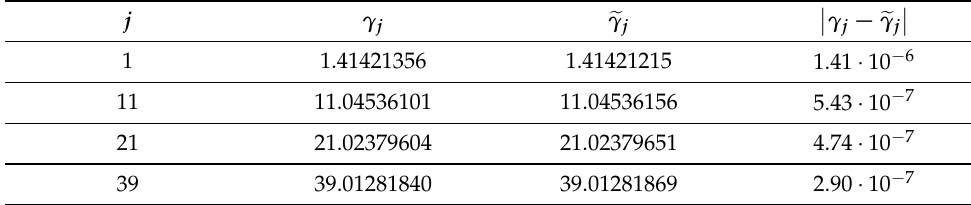
Table 2. Dirichlet–Dirichlet singular numbers of q from Example